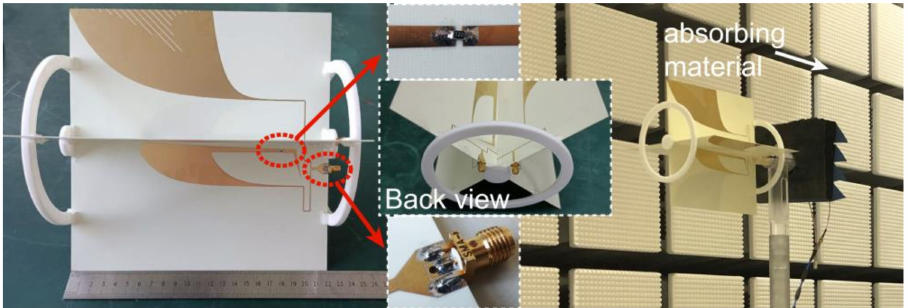
Figure 7. The fabricated dual-loop loaded DP-DSATSA and the test scene in the microwave ane- choic